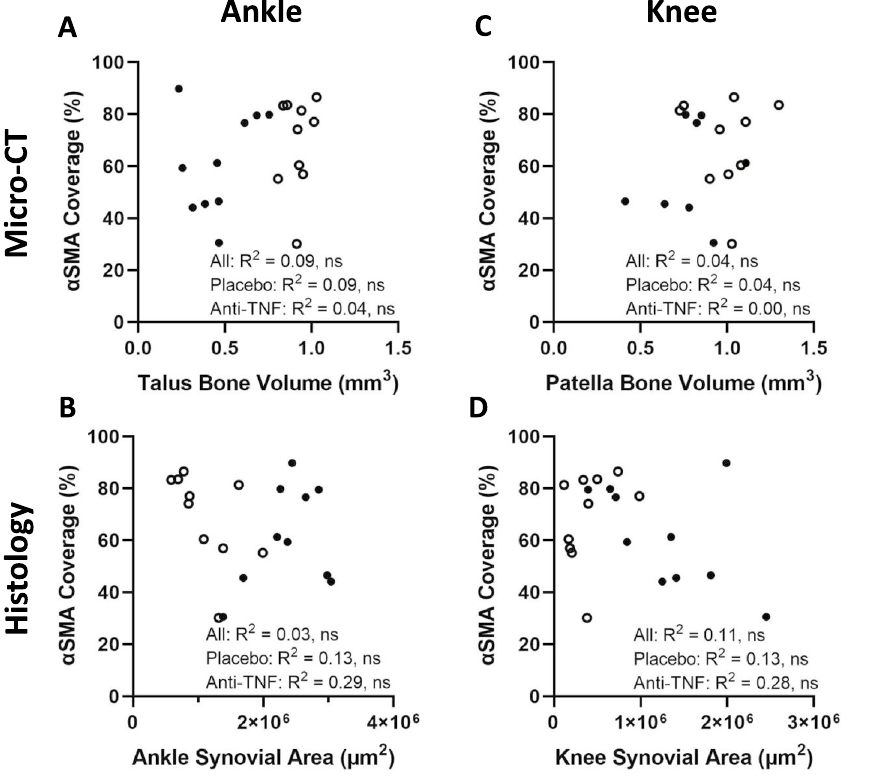
Figure 3. Joint erosions and synovitis are unrelated to αSMA+ LMC coverage of PLVs. To investigate the relationship between joint disease and αSMA + PLV-LMC coverage, we performed linear regression analysis with bone volumes by micro-CT or synovial areas by histology for placebo (closed circles) and anti-TNF (open circles) treated TNF-Tg mice. We found no association between talus bone volumes (A) or synovial area in the tarsal region (B) of the ankles with the αSMA + PLV-LMC coverage regardless of treatment. Similarly, there was no relationship between patella bone volumes (C) or synovial area (D) of the knee with αSMA + PLV-LMC coverage for both TNF-Tg treatment cohorts. Statistics: Linear regression analysis with R 2 and p -value provided for placebo and anti-TNF combined (All) or the treatment groups separately; no significance (ns), p > 0.05 . Sample size: Each datapoint represents an individual limb with the average αSMA + PLV-LMC coverage of the two PLVs per limb from TNF-Tg placebo and TNF-Tg anti-TNF cohorts (n = 5 mice, n = 10 limbs per